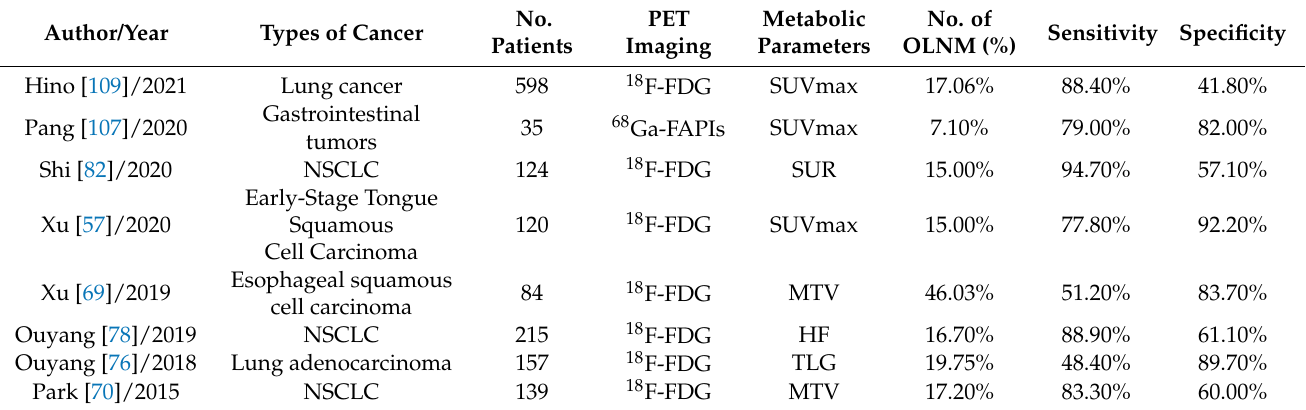
Table 3. The clinical significance of using PET/CT to detect the